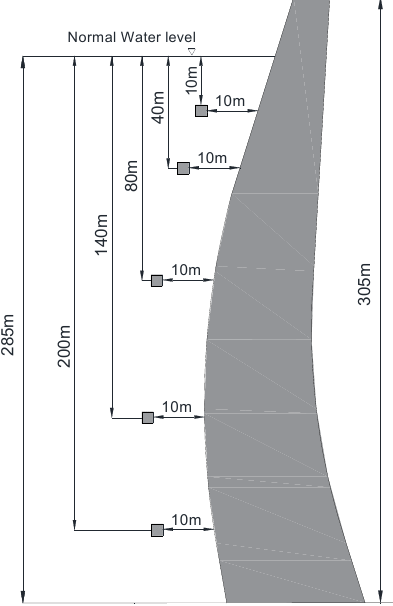
Figure 14. Detonation positions at various detonation depths.